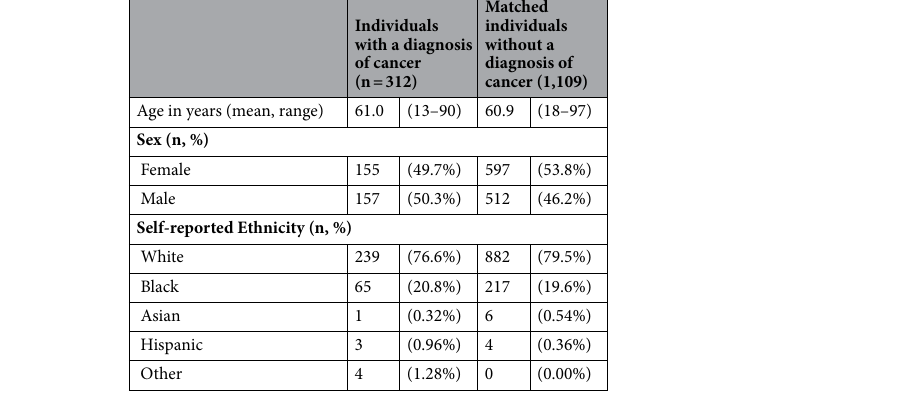
Table 5. Study sample